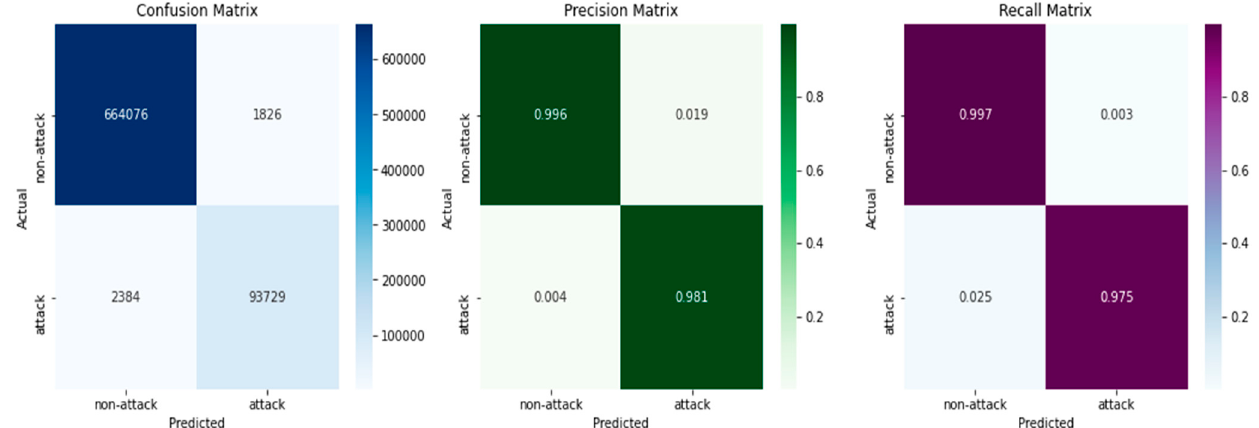
Figure 6. Train and Test confusion matrix.